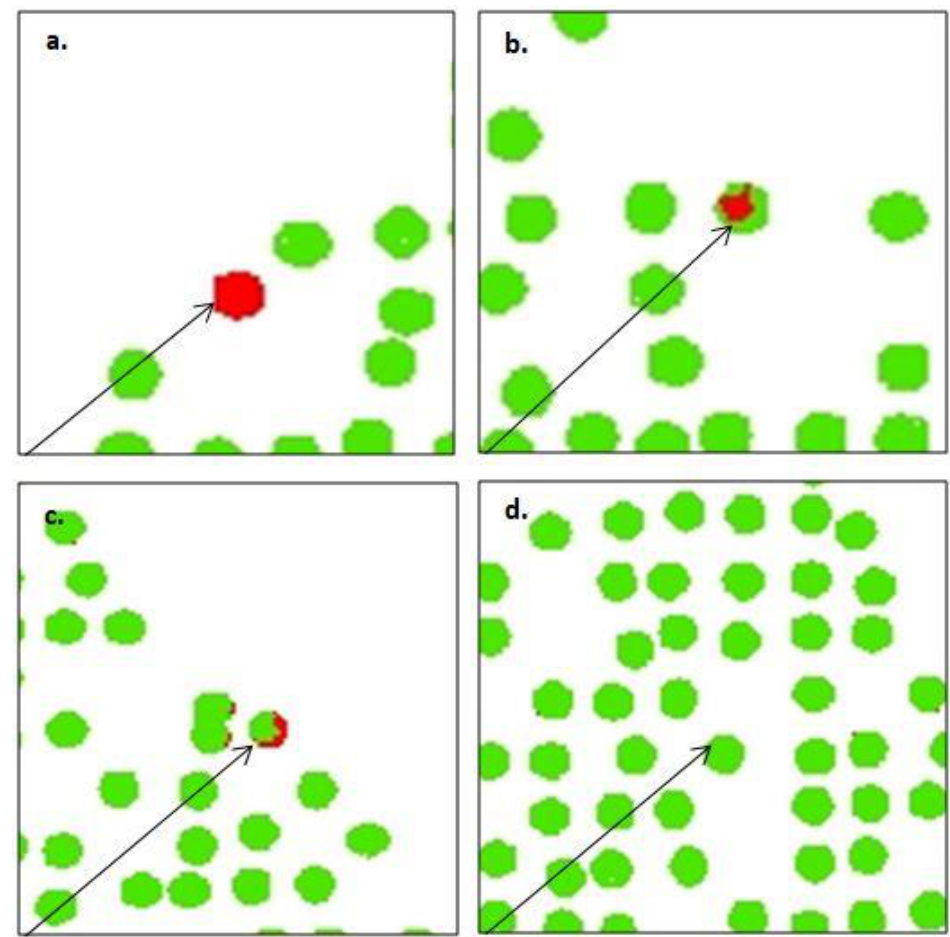
Figure 6. VARI-green classification of four health status indices: ( a ) Dead. ( b ) Severe infection. ( c ) Mild infection. ( d ) Healthy. ( c ) Mild infection. ( d )